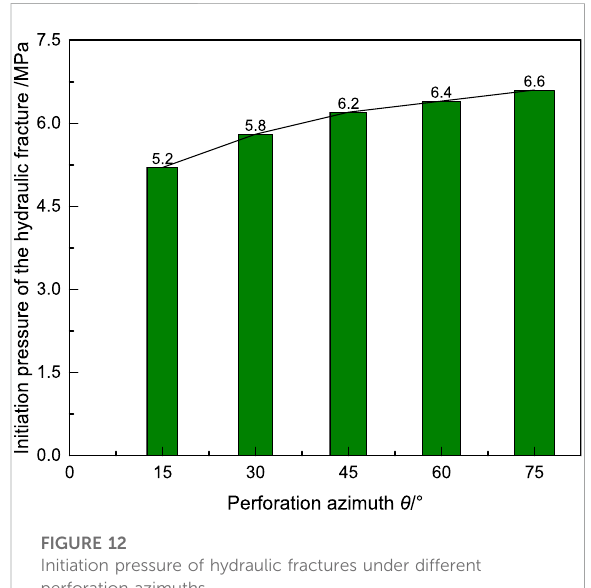
FIGURE 12 Initiation pressure of hydraulic fractures under different perforation